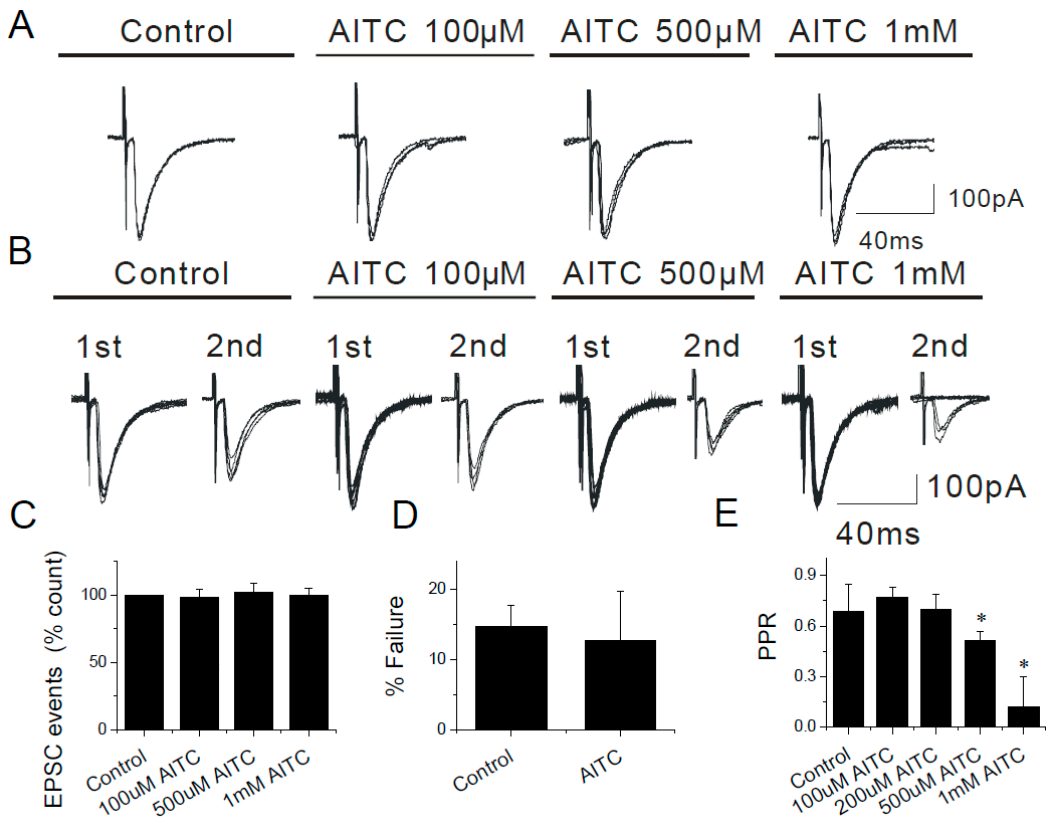
Figure 9. AITC-induced e ff ects on solitary tract-evoked synaptic responses in horizontal brainstem slices. ( A , B ) Representative traces of solitary tract-stimulated EPSCs (ST-EPSCs) showing seven overlapping sweeps. ( A , C ) AITC does not have any significant e ff ect on the amplitude of the ST-EPSCs ( n = 14). ( B , E ) AITC depressed the paired pulse ratio (PPR, EPSC2 / EPSC1) in a concentration dependent manner. ( D ) AITC does not show any significant e ff ect on the failure rate (% failures = (number of failures / total stimulations) × 100%) in NTS neurons ( n = 11). The asterisk (*) represents p < 0.05 as compared to control.